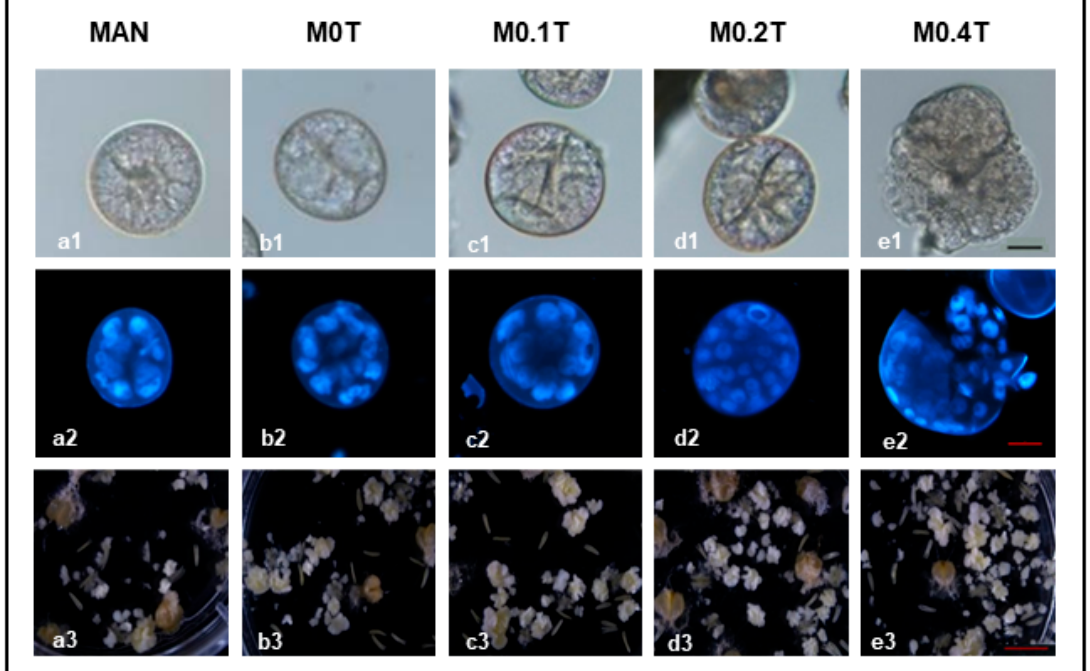
Figure 1. Microspore embryogenesis of bread wheat after the application of different concentrations of trichostatin A (TSA) simultaneously with mannitol stress treatment. Multicellular structures (enclosed by the exine) and proembryos (multicellular structures released from the exine) ( a1 – e1 and a2 – e2 ) at 10 days of culture and mature embryos and callus-like structures ( a3 – e3 ) at 40 days of culture from cv. Pavon. a1 – e1 : bright field images; a2 – e2 : dark field images of multicellular structures and proembryos stained with DAPI. a1 – a3 ) MAN = 0.7 M mannitol; b1 – b3 ) M0T = 0.7 M mannitol with 1% DMSO; c1 – c3 ) M0.1T = mannitol with 0.1 µM TSA; d1 – d3 ) M02T = mannitol with